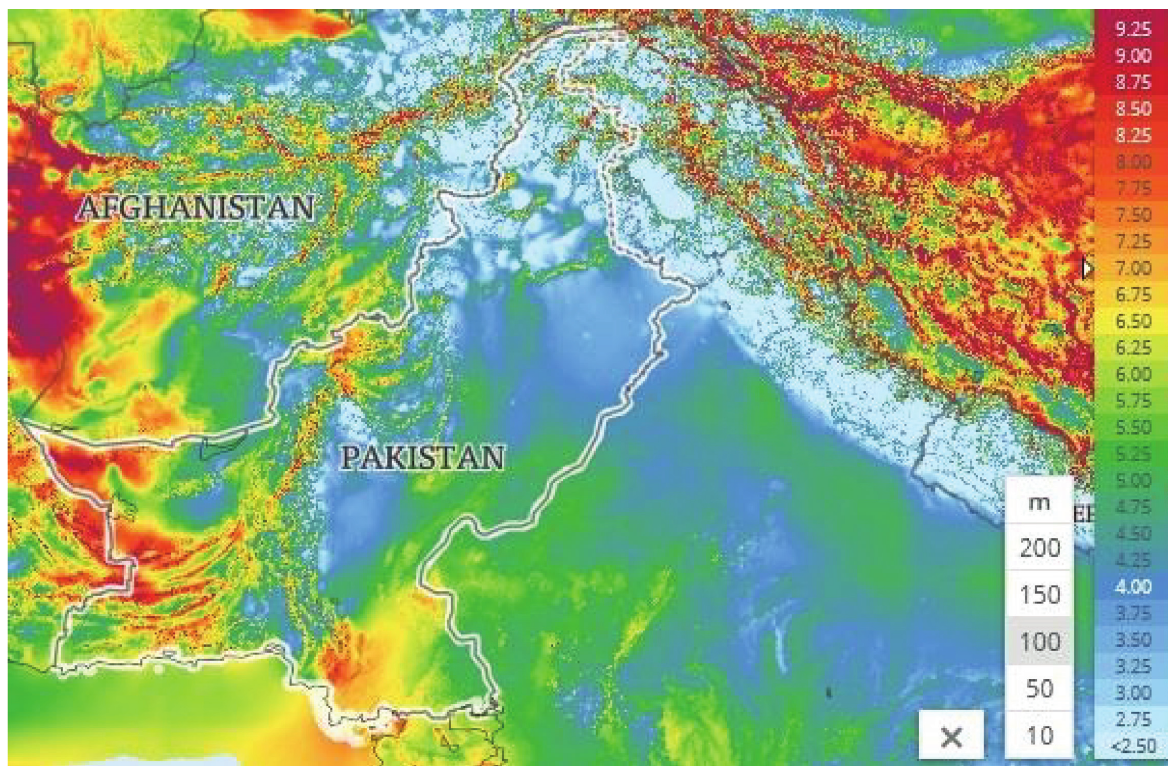
Figure 3: Atlas of wind speed at an elevation of 100m